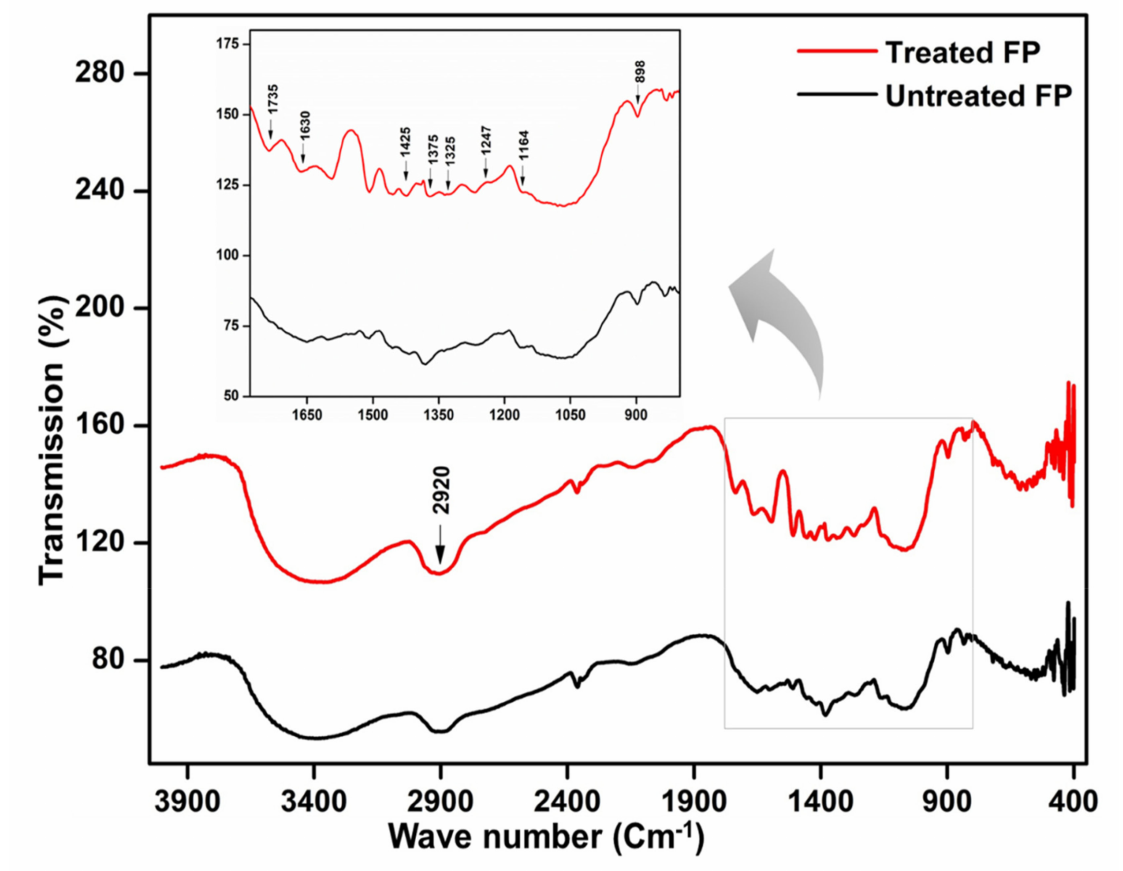
Figure 8. FTIR analyses of filter paper before and after hydrolysis by the bacterium B. altitudinis RSP75. The FP was used as the sole source of carbon for the growth of the